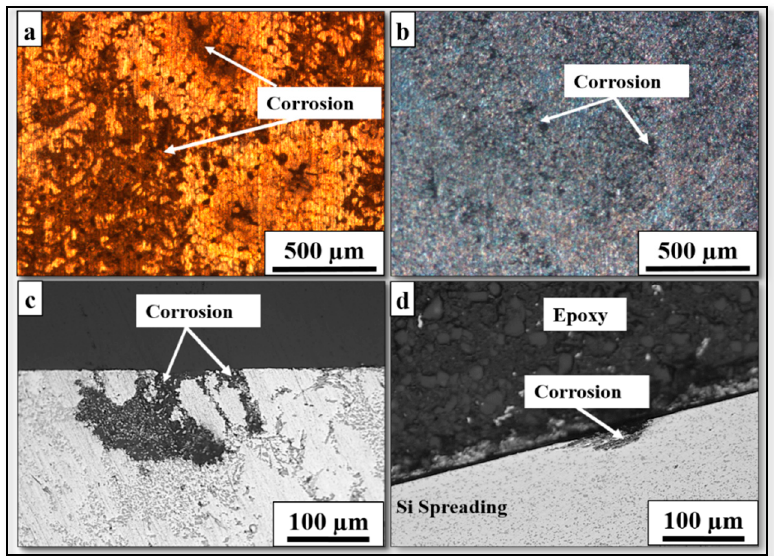
Figure 9. Surface appearance of the ( a ) A356 Al alloy; ( b ) HPTed heat-treated A356 Al alloy; side view of the ( c ) A356 Al alloy and ( d ) HPTed heat-treated A356 Al alloy after immersion for 10